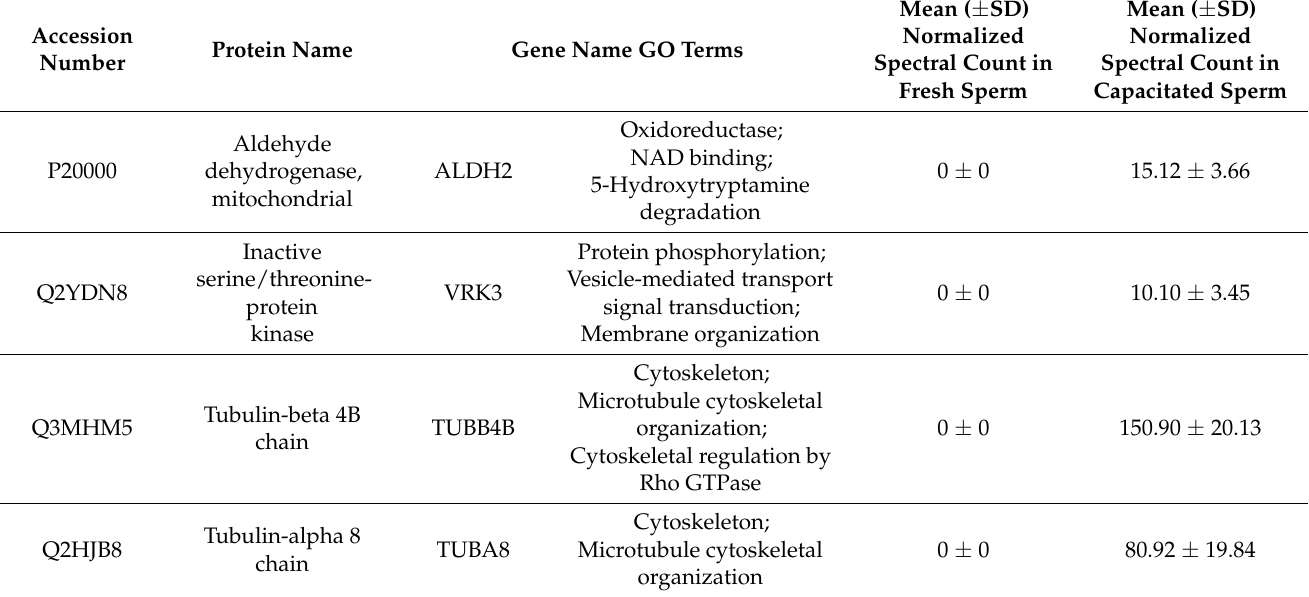
Table 2. Mean normalized spectral counts ( ± SD) as a measure of quantified abundance proteins interacting with tACE exclusively identified in capacitated bovine sperm (n = 3) using liquid chro- matography and tandem mass